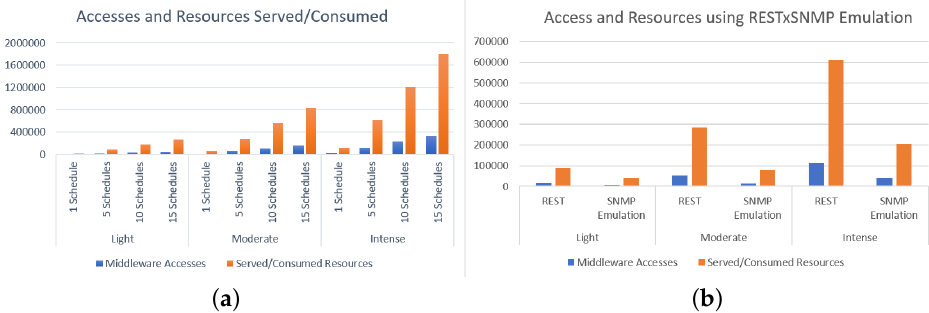
Figure 8. ( a ) Accesses and resources served/consumed by the Middleware. ( b ) HTTP sessions opened using REST x REST with SNMP